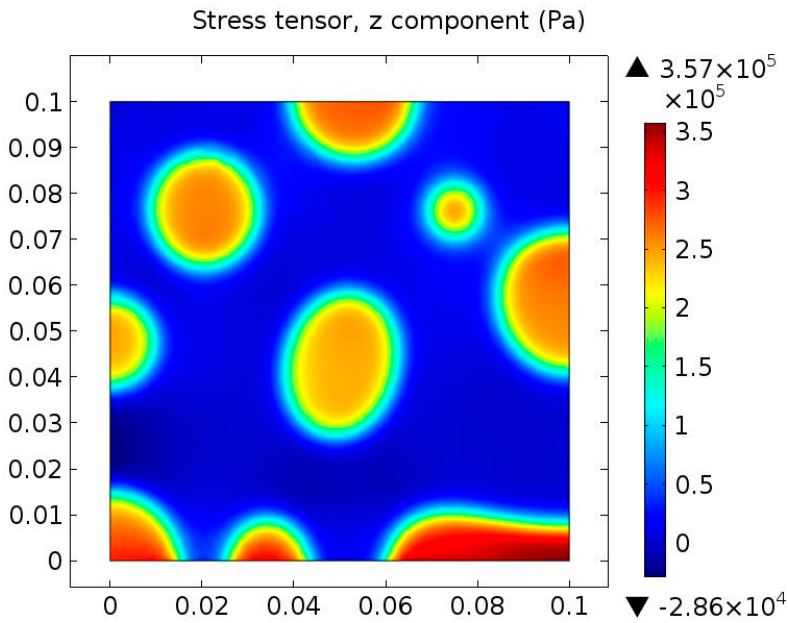
Figure 12. z component of stress tensor at t = 0.05 s.